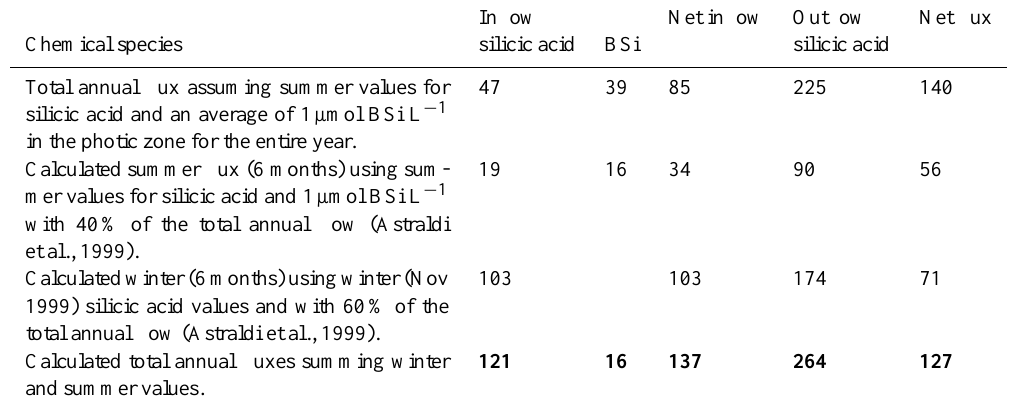
Table 2. Table showing the depth-averaged concentration of dissolved silicate (in µmolkg − 1 ) measured for the series of stations across the Straits of Sicily sampled during the MATER-MTP cruises between 1996 and 1999 (data were obtained from Lavezza et al., 2011). Depth averaged concentration of Depth-averaged concentration of Cruise name, time of sampling SA in the layer flowing out of the SA in layer flowing into the and number of stations averaged EMS EMS; depth of layer in brackets in brackets MATER 1; Sep 1996 (24)